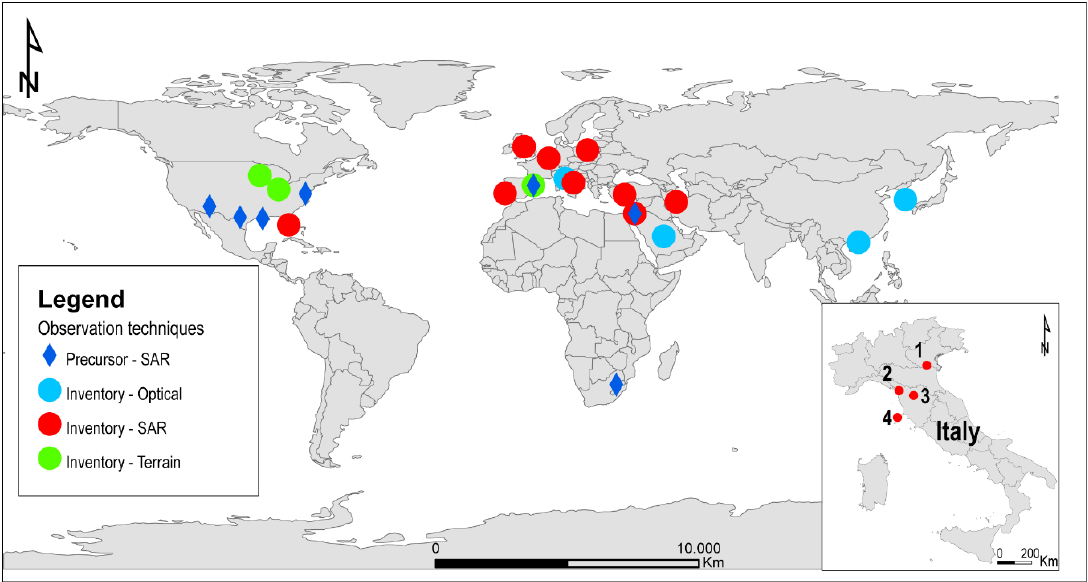
Figure 2. Observation techniques have been used worldwide for sinkhole precursor detection (blue rhombus) and sinkhole inventory using optical remote sensing (blue circles), remotely generated terrain models (green circles) and SAR techniques (red circles) [44–59]. The figure has been updated and modified only concerning the SAR part after Theron et al. 2018 [37]. In the box, SAR technique applied in the Italian territory to detect subsidence phenomena is shown: (1) Rovigo (Veneto region); (2) Camaiore (Tuscany region); (3) Prato (Tuscany region); (4) Elba island (Tuscany region).